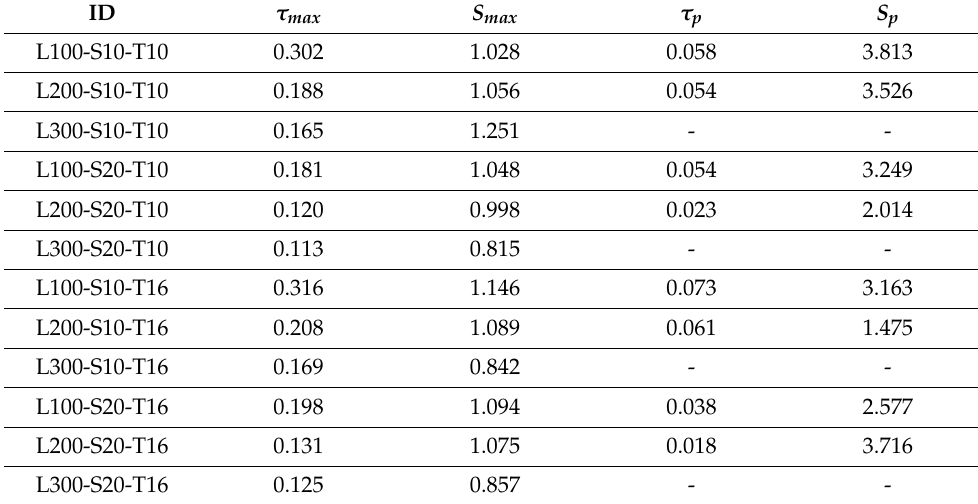
Figure 9 compared the average experimental curves with theoretical curves. The